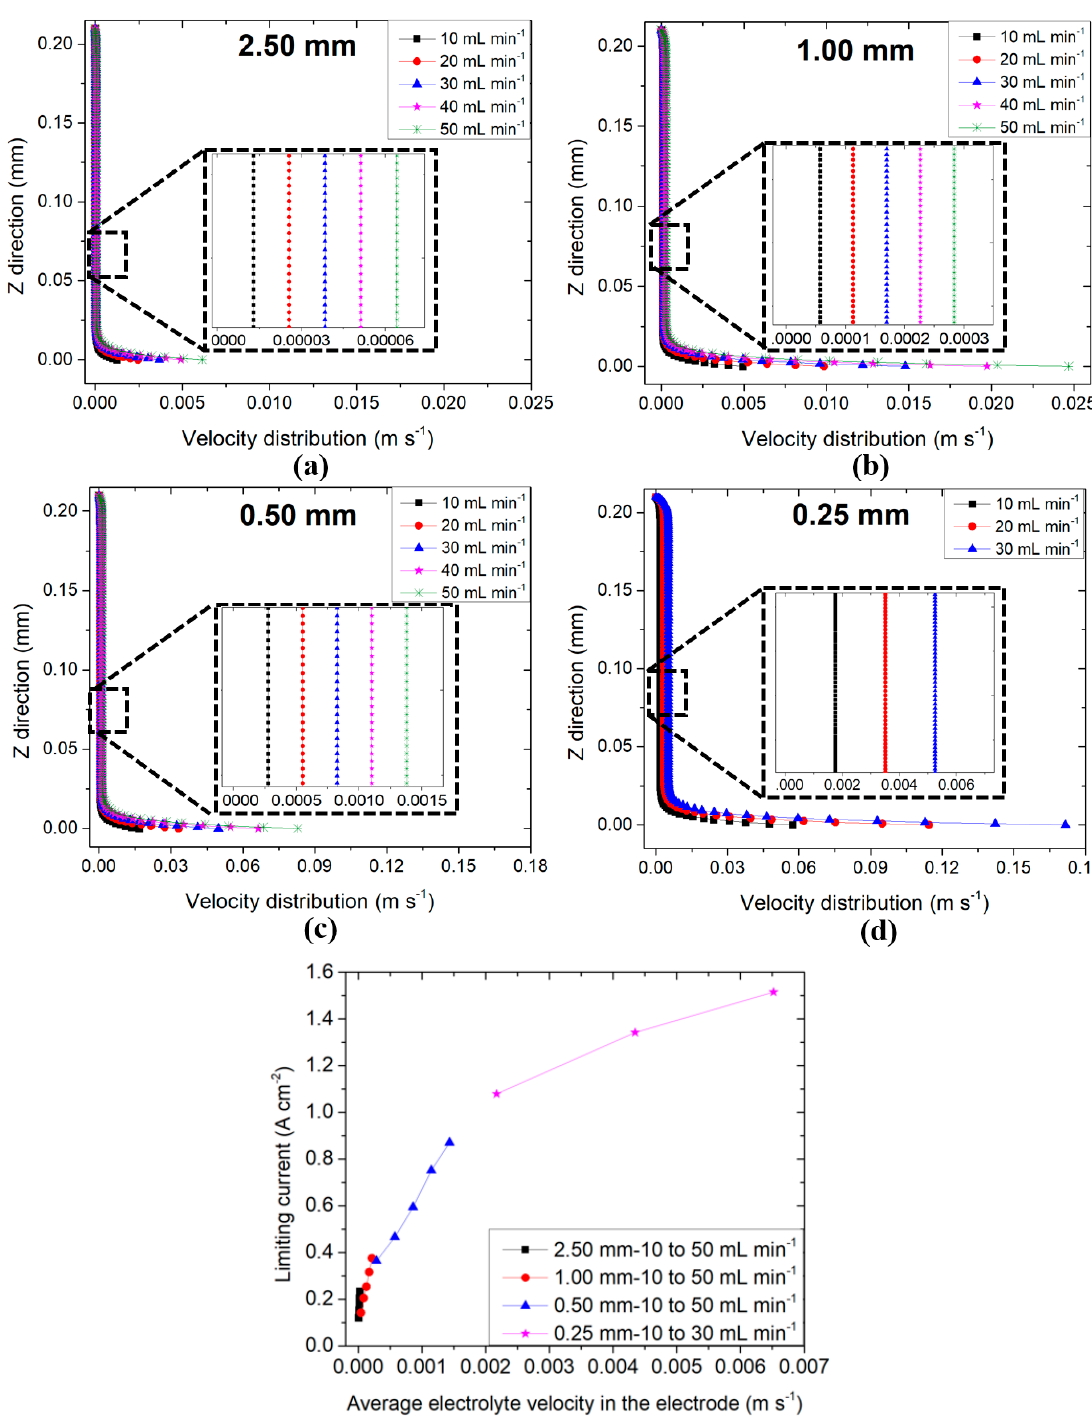
Figure 3. Predicted electrolyte velocity distribution at a cut line in the center of the electrode and channel domain: ( a) 2.5 mm ( b ) 1 mm ( c ) 0.50 mm ( d ) 0.25 mm and ( e ) correlation between average channel velocity and measured limiting currents.